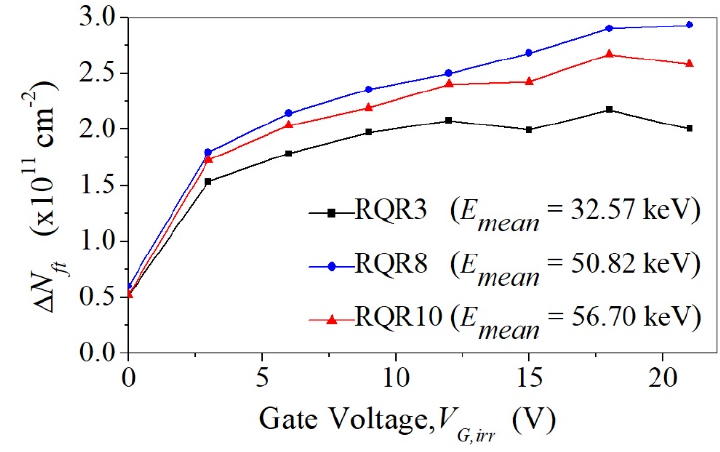
Figure 6. ∆ N ft at K air = 50 Gy versus gate voltage during irradiation.